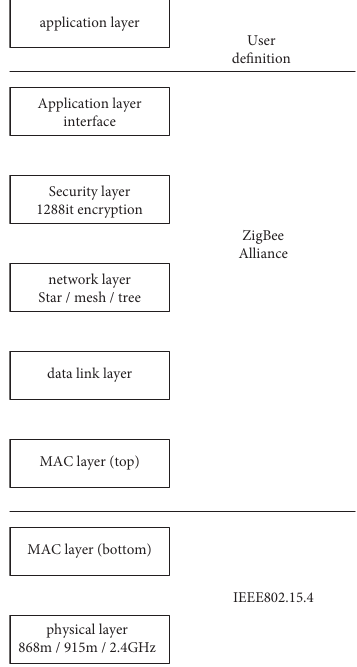
Figure 1: Structure and division of labor of Zigbee